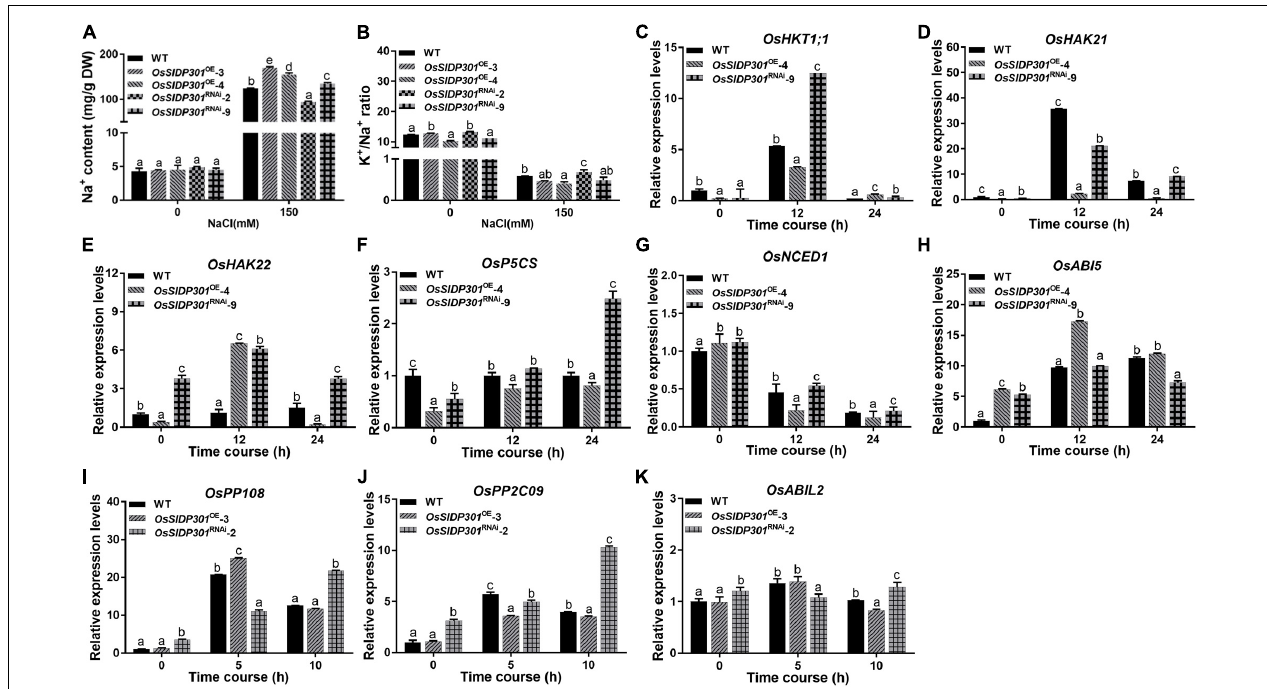
FIGURE 5 | The expression levels of salt stress and ABA-related genes. The Na + content (A) and K + /Na + ratio (B) of 3-week-old plant leave with or without 150 mM NaCl treatment. (C–H) The expression level analysis of ion transporter OsHKT1;1 , OsHAK21 , OsHAK22 , and salt-response genes OsNCED1 , OsP5CS , and OsABI5 with or without 150 mM NaCl treatment by using 2-week-old seedlings. (I–K) The expression level analysis of ABA signaling regulators OsPP108 , OsPP2C09 , and OsABIL2 with 100 µ M ABA treatment by using 2-week-old seedlings. Data are shown as mean ± SD ( n = 3), different letters suggested significant differences at P <